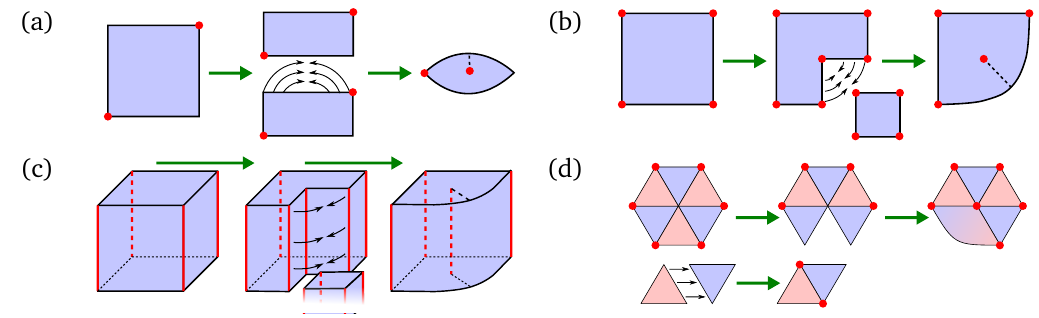
Figure 4: Volterra processes to construct disclinations in systems with second-order topology and different rotation symmetries: (a) twofold symmetry in two dimen- sions, (b) four-fold symmetry in two dimensions, (c) four-fold symmetry in three dimensions, (d) sixfold symmetry in two dimensions. Red dots and red lines indicate anomalous corner and hinge modes, respectively. In (d), adjacent triangles in red and purple are related by a sixfold